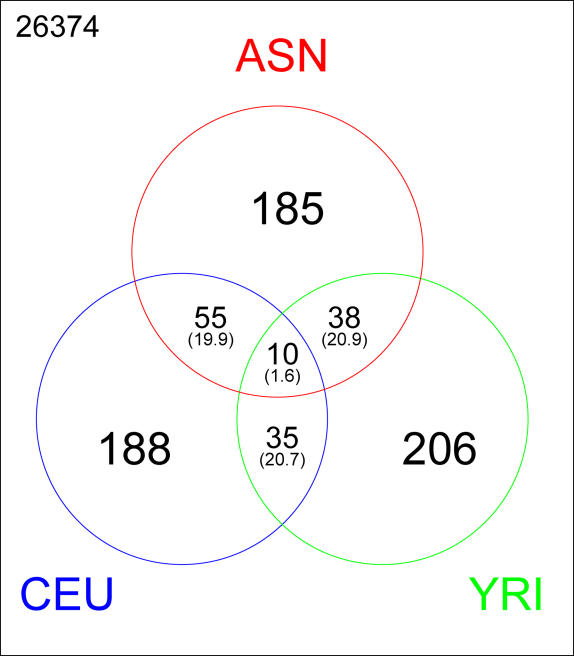
Sharing of iHS Signals between PopulationsThe numbers listed inside circles represent the numbers of 100-kb windows that are in the top 1% of the empirical distributions in at least one population. The numbers in the intersection regions are in the top 1% for one population, and the top 5% for one or both of the other populations. The counts that would be expected if signals were independent across populations are shown in parentheses. The number of windows not in any circle is reported in the upper-left corner.